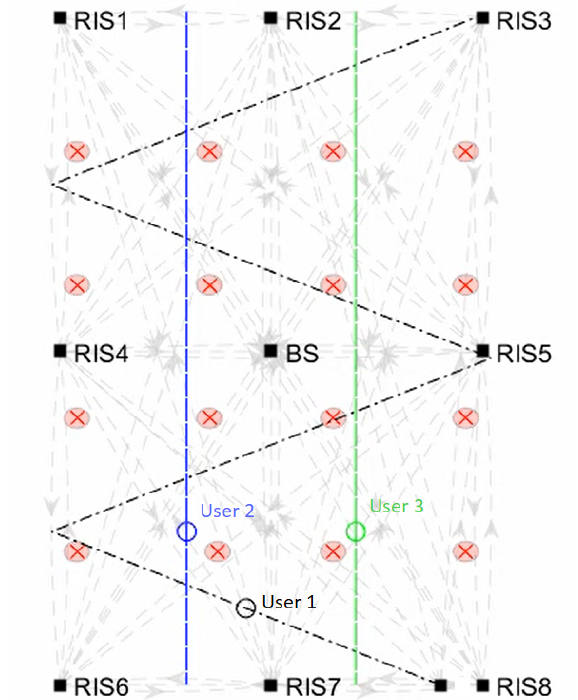
Figure 7. Multi-user composite mobility pattern: two users follow a linear trajectory (blue and green lines), while the third user follows a zig-zag trajectory (black